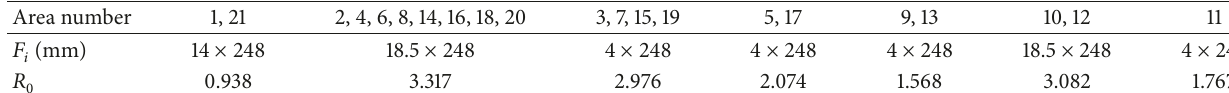
Table 4: Thermal parameters of hollow shale block walls.